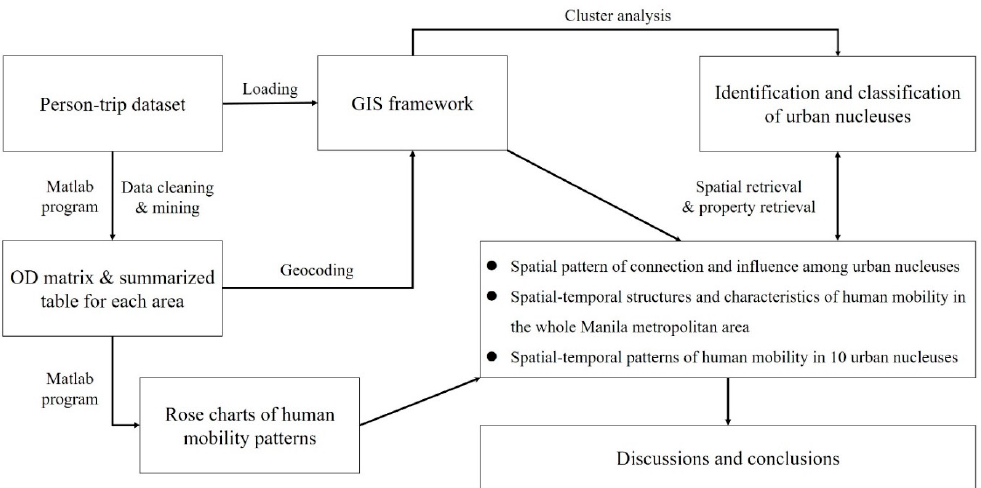
Figure 2. Study framework.